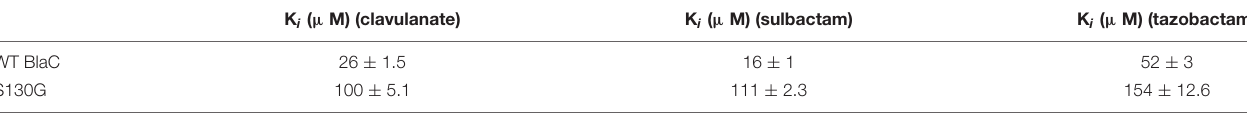
Table 2 | Inhibition kinetic parameter of three mechanism-based inhibitors (clavulanate, sulbactam, and tazobactam) toward wild-type BlaC and S130G variant. K i ( µ M)